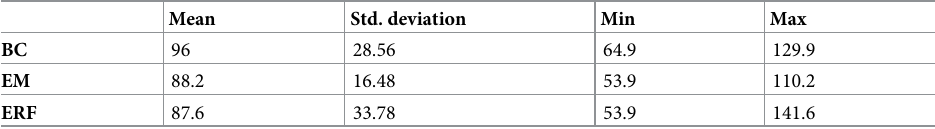
Table 2. Trueness RMS values ( μ m) for all stone models.